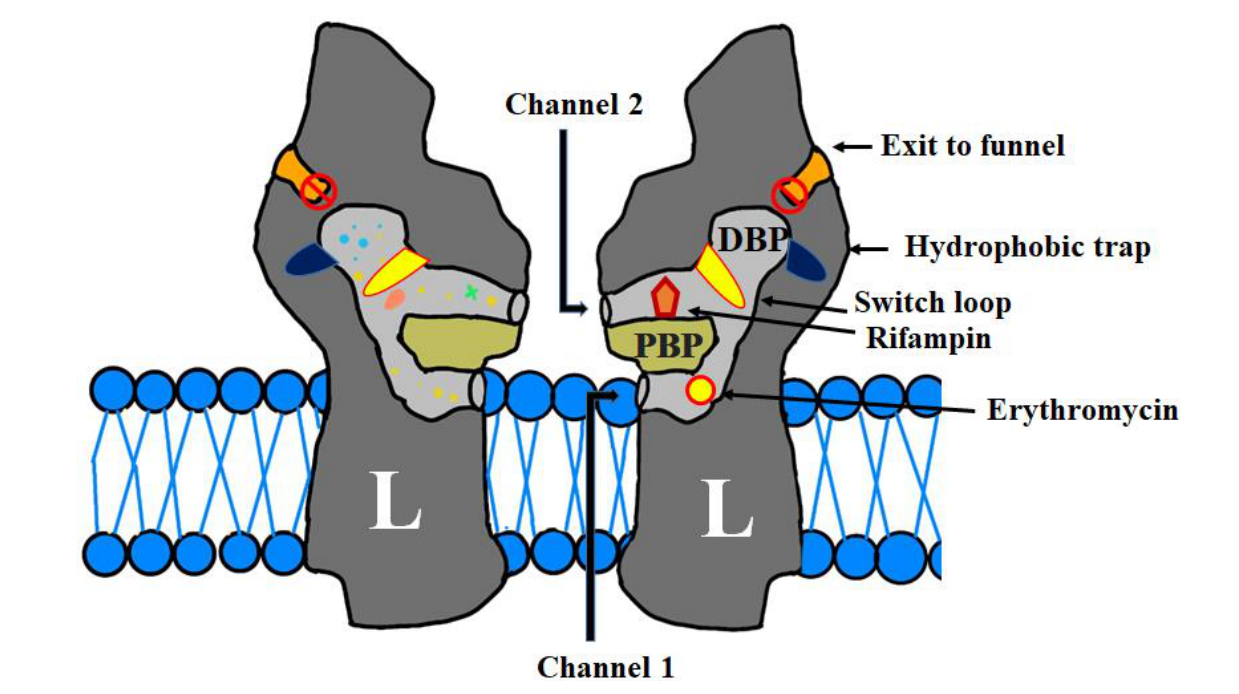
Figure 5. Schematic diagram depicting drug pathways in AcrB and the drug-binding pockets and the two channels that transport substrates are depicted. The periplasmic entry site (channel 2) includes the proximal binding pocket (PBP) in the L protomer, while channel 1 guides substrates from the inner membrane leaflet. The binding sites for rifampicin and erythromycin, co-crystallized in the access pocket in the L monomer, are shown. Minocycline and doxorubicin bind in the deep binding pocket within the T monomer (not shown). The switch loop that separates the proximal and distal binding pockets is also shown. Moreover, the schematic diagram shows the proximal and distal binding pockets of AcrB and a switch loop that separates them, which assists in the unidirectional movement of substrates, whereas smaller substrates and low-molecular-mass drugs localize in the deeper DBP. The two entry channels for substrates connect together leading to the distal binding pocket shown, as is the exit channel that leads from the central cavity to TolC.